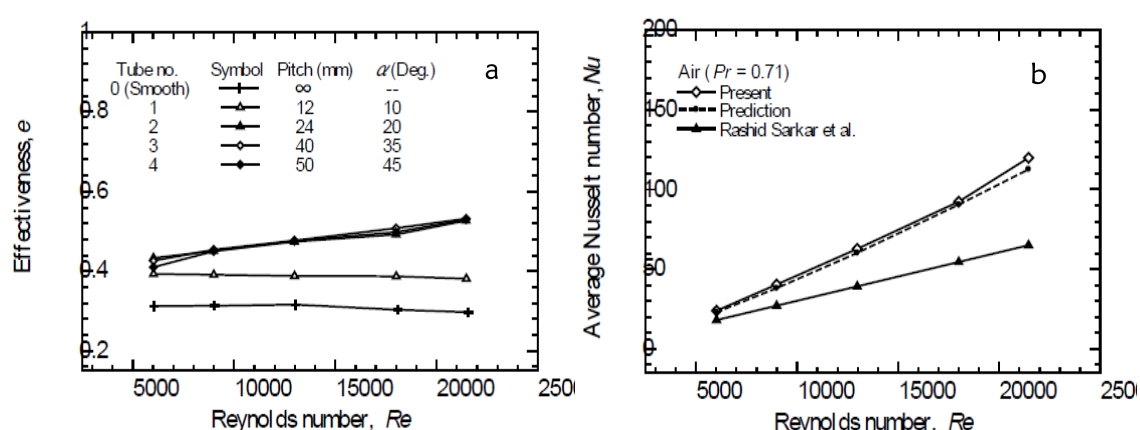
Figure 12: (a) Variation of average effectiveness against Reynolds number for smooth tube and wire-coil inserted tubes. (b) Prediction of heat transfer coefficients for wire-coil inserted tube (Pitch =50 mm, helix angle, α =450) [19].